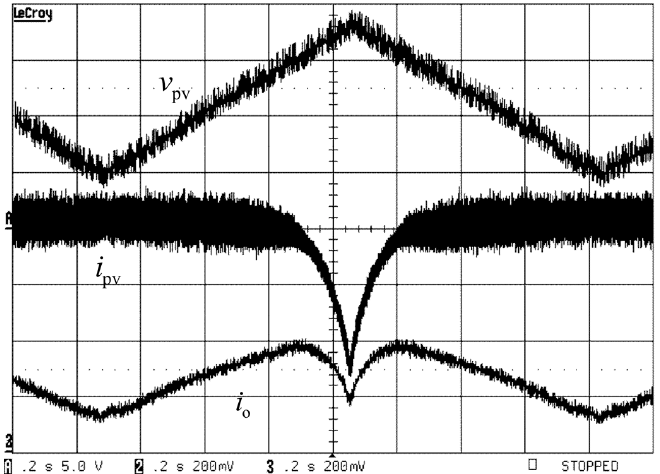
v ) and current ( i ) as well as input-voltage- pv pv i ), when the operating point of Raloss SR30-36 PV o